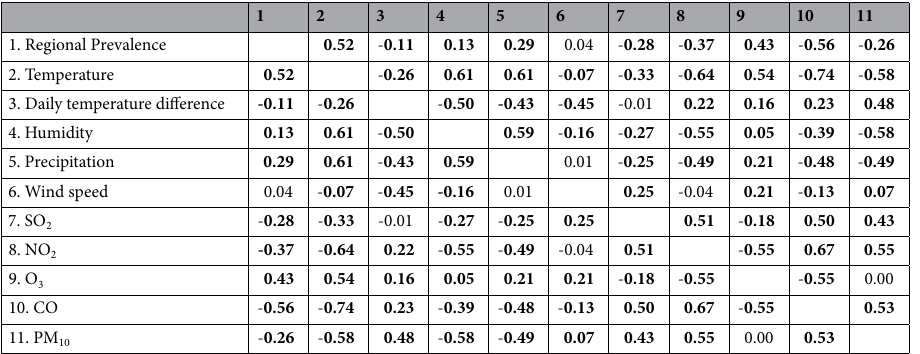
Table 1. Correlation coefficients of variables using correlation analysis between prevalence and temperature or air quality parameters. Average temperature, humidity, precipitation, and ozone showed positive correlation, daily temperature difference, average wind speed, sulfur dioxide, nitrogen dioxide, carbon monoxide and PM 10 showed negative correlation. SO 2 , sulfur dioxide; NO 2 , nitrogen dioxide; O 3 , Ozone; CO, carbon monoxide;